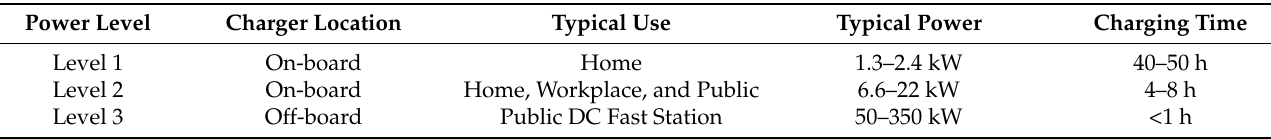
Table 1. EV battery chargers